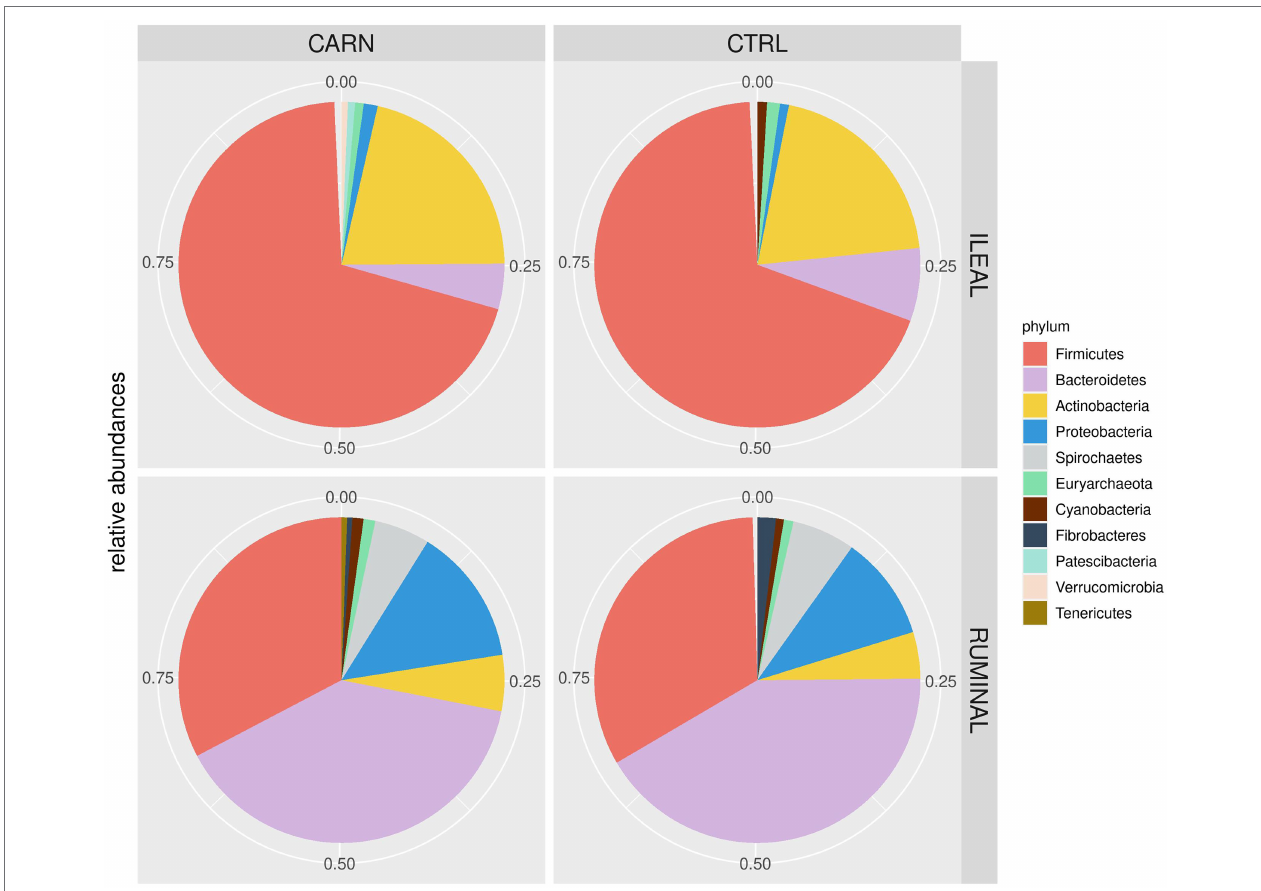
FIGURE 2 | Pie chart of relative abundances at the phylum level in the microbiota of ileum and rumen of early feed restricted lambs being fed the control (CTRL) or the L-Carnitine diet (CARN) during the fattening